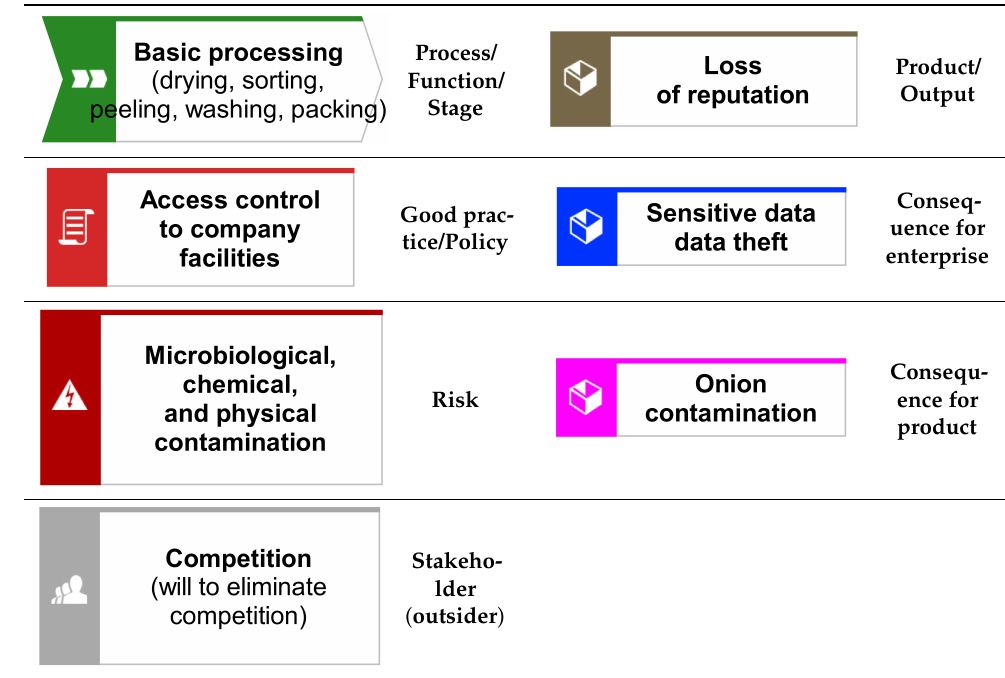
Table 4. CARVER+Shock criticality grading scales in the case of onion production. Source: [46].